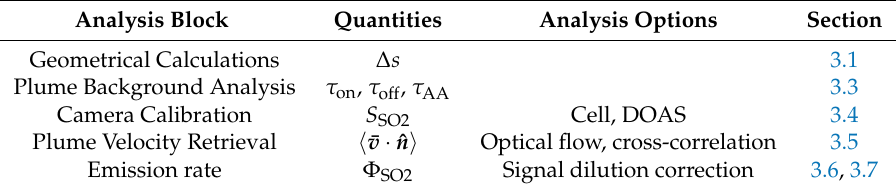
Table 1. Analysis blocks for emission rate retrievals (for details see Section